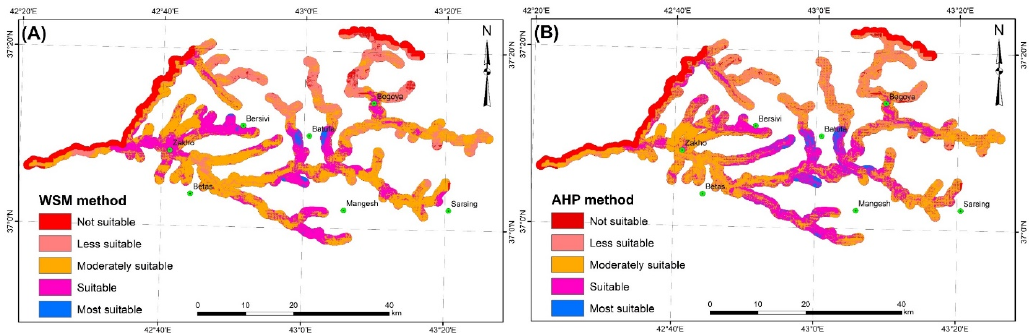
Figure 12. Distribution of suitability maps of dam site using ( A ) weighted sum method (WSM) and ( B ) analytic hierarchy process (AHP) with buffer of 1000 m.